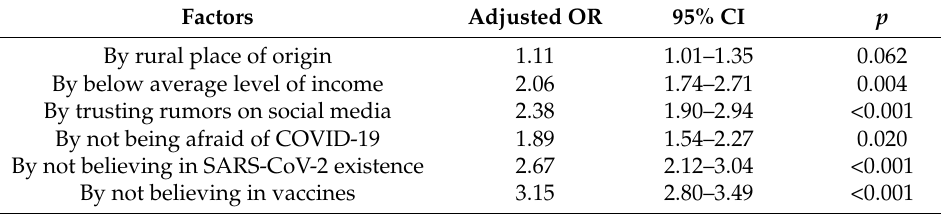
Table 5. Adjusted Odds Ratios for factors associated with overall hesitancy in pregnant women. Factors Adjusted OR 95% CI p By rural place of